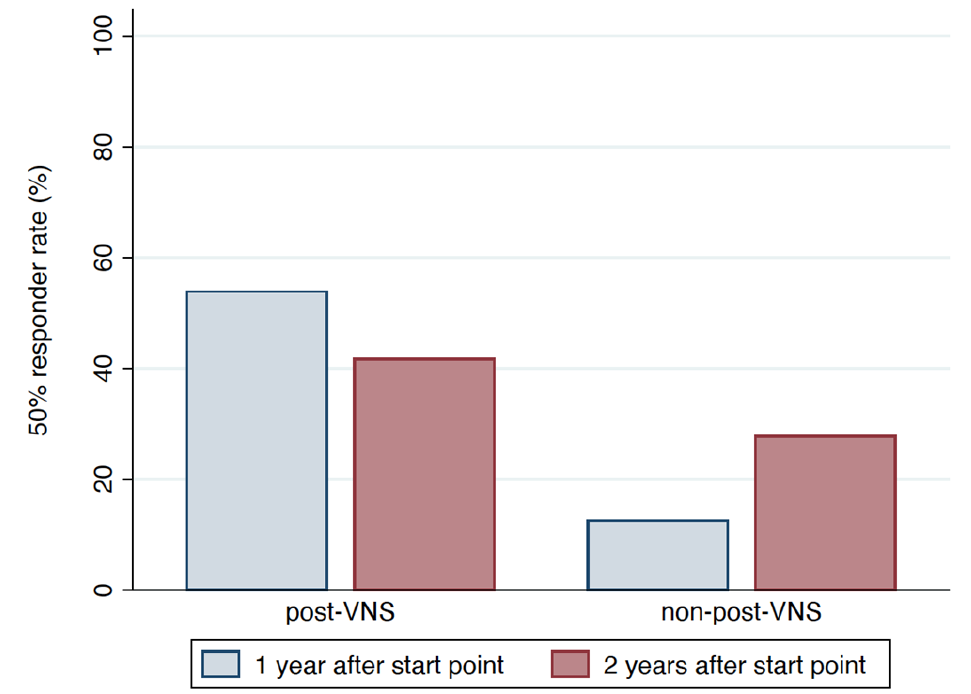
Figure 2. Histogram illustrating the frequency of achieving responder status ( ≥ 50% reduction in seizure frequency) at 1 year after start point was 53.85% in the post-VNS group and 12.5% in the non-post-VNS group (blue, p = 0.017, Fisher’s exact test). The frequency of achieving responder status at 2 years after the start point was 41.67% in the post-VNS group and 27.78% in the non-post-VNS group (red, p = 0.461, Fisher’s exact